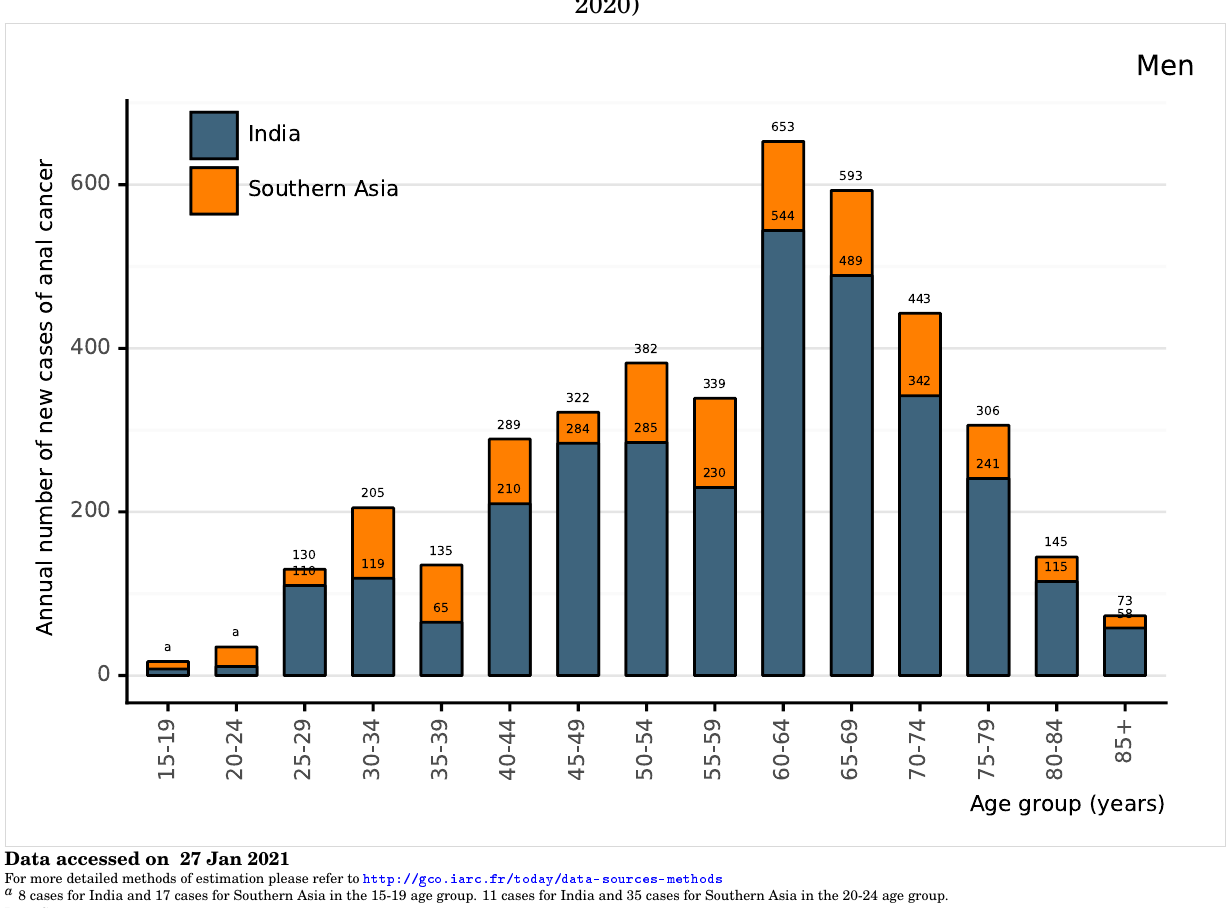
Figure 77: Annual number of new cases of anal cancer among men by age group in India (estimates